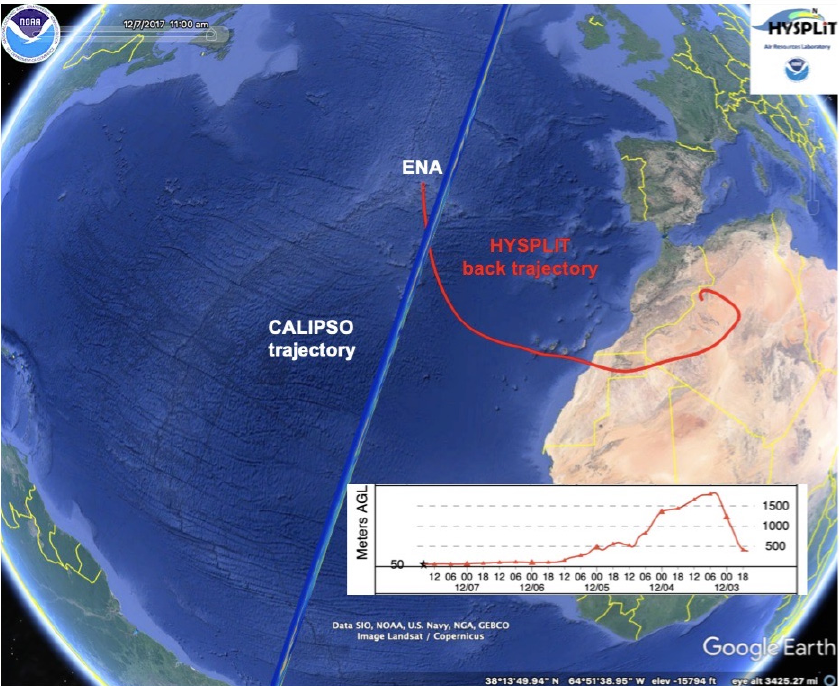
Figure 4. CALIPSO trajectories (blue) and HYSPLIT back trajectories (red) arriving at 50ma.g.l. above the ENA site on 7 December 2017 (© Google Earth